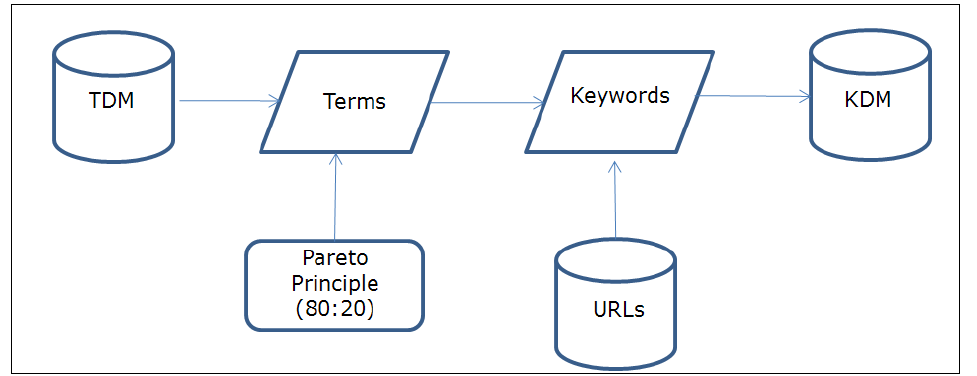
Figure 4 . Formation of the KDM by normalizing the TF-IDF values of the terms in the TDM and applying the Pareto principle empirically for feature